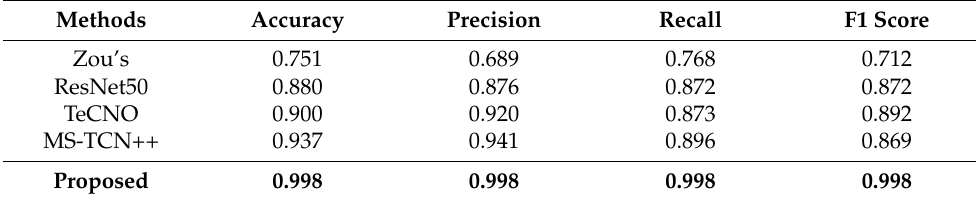
Table 1. Quantitative results for organ classification. The proposed method (i.e., ResNet50 + temporal filter) yields the best